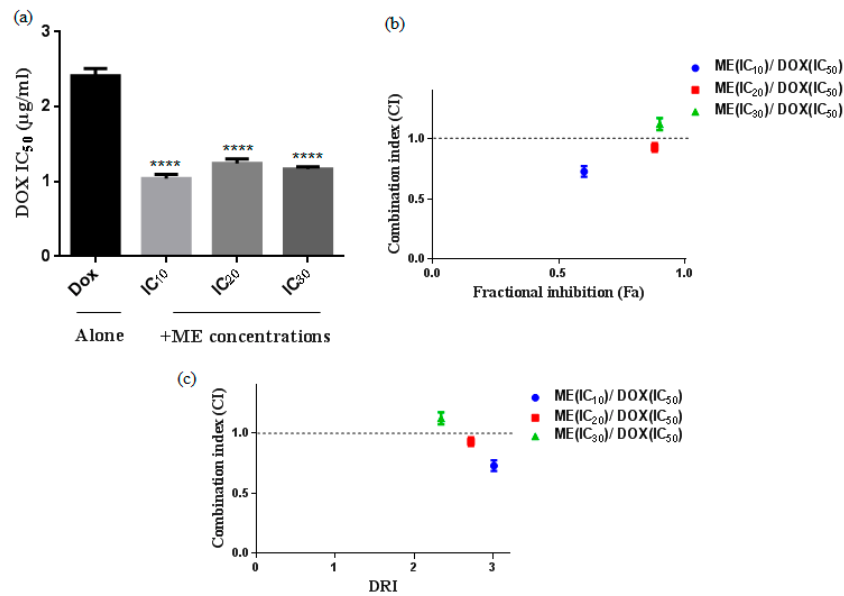
Figure 3. Cytotoxic effect of doxorubicin (Dox) alone or in combination with ME (IC 10 , IC 20, and IC 30 ) against Caco-2 cells for 48 h. ( a ) IC 50 was analyzed by MTT assay **** p < 0.0001 compared to the untreated DMSO control by one-way ANOVA. ( b ) The combination index (CI) and (DRI) plots were constructed according to the data obtained from the CompuSyn reporting ME (IC 10 , IC 20, and IC 30 ) and Dox combinations. CI values indicate additive (CI = 1), synergistic (CI < 1), and antagonistic (CI > 1) effects. ( c ) Fractional response (Fa). Data represent the mean ± standard deviation of the mean of 3 independent experiments.